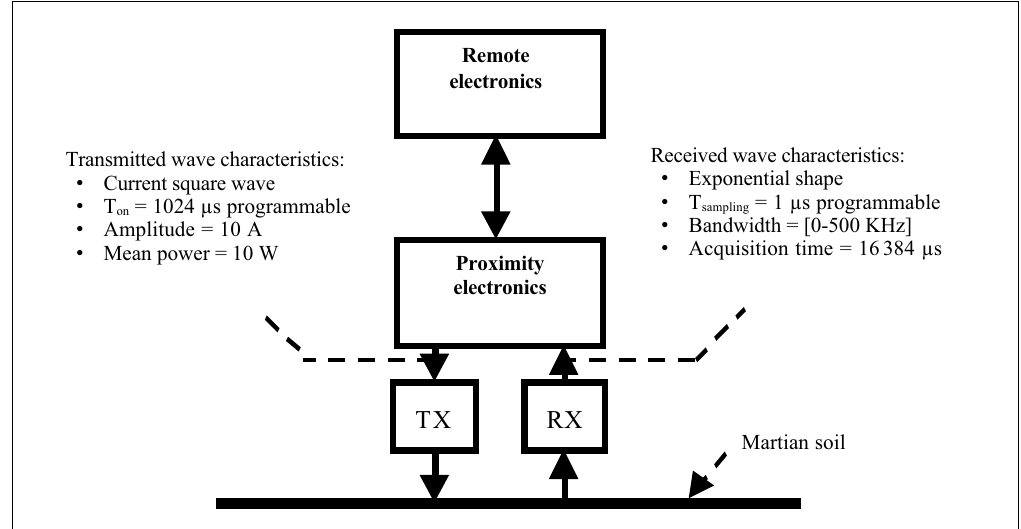
Fig. 2. Scheme of the TDEM system designed for